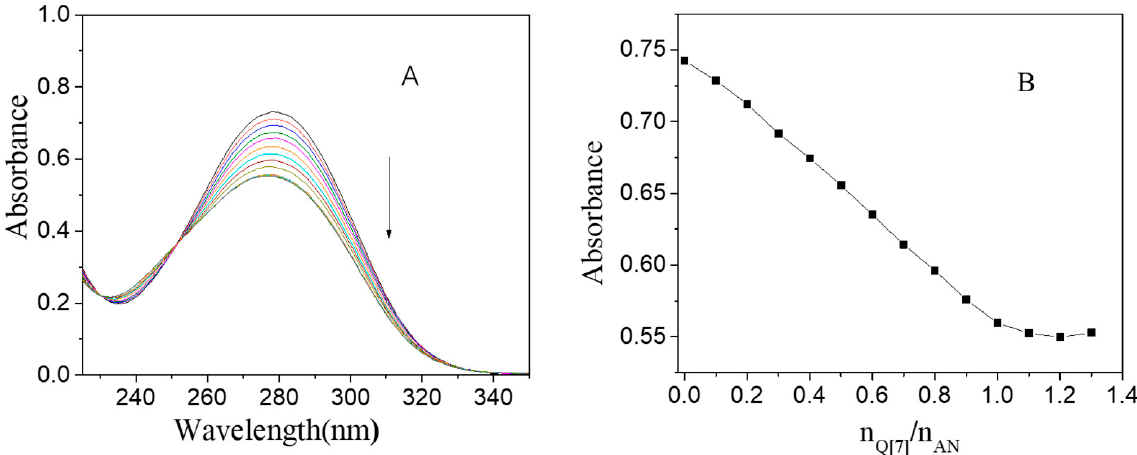
Figure 3. ( A ) The UV-vis spectrometry of the solution of AN with adding Q[7] at different concentrations. ( B ) The maximum absorption peak corresponding to the ratio of N (Q [7])/N (AN).